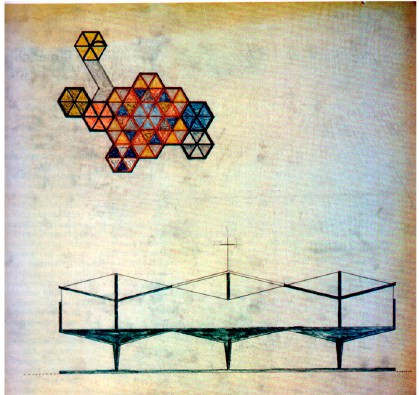
Figure 23. Tony Smith’s plan for a Catholic church, 1951–1952, © 2022 Tony Smith Estate/Artists Rights Society (ARS), New York. The upper portion represents the church’s ceiling, the lower, a central cross-section. central